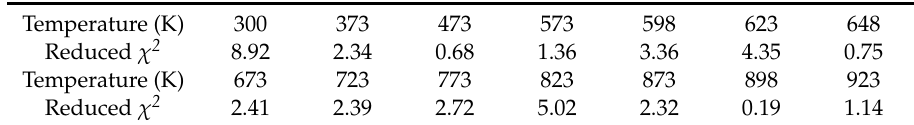
Table 2. Reduced χ 2 values obtained for Voce relationship at different temperatures for present CLAM steel at strain rate of 2 × 10 −4 s −1 .